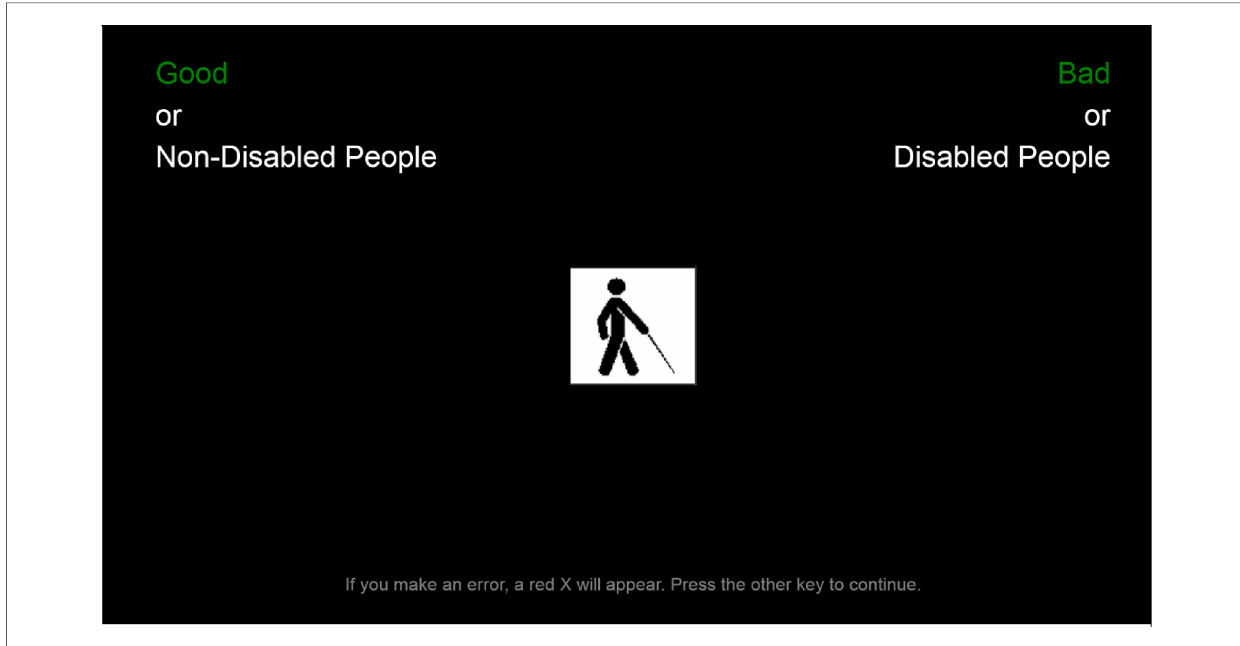
FIGURE 1 Screenshot of the disability IAT. Note: Since the preferred terminology in the UK is “ disabled people ” rather than “ people with disabilities ” , the term “ disabled people ” was used in the materials presented to participants.